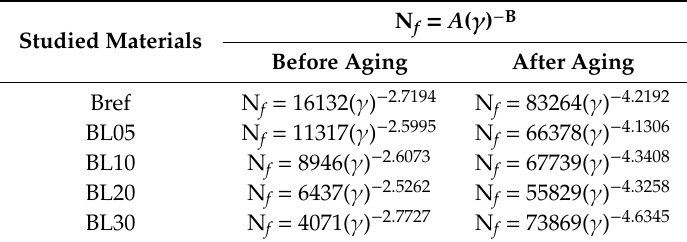
Table 3. Fatigue fitting functions of studied